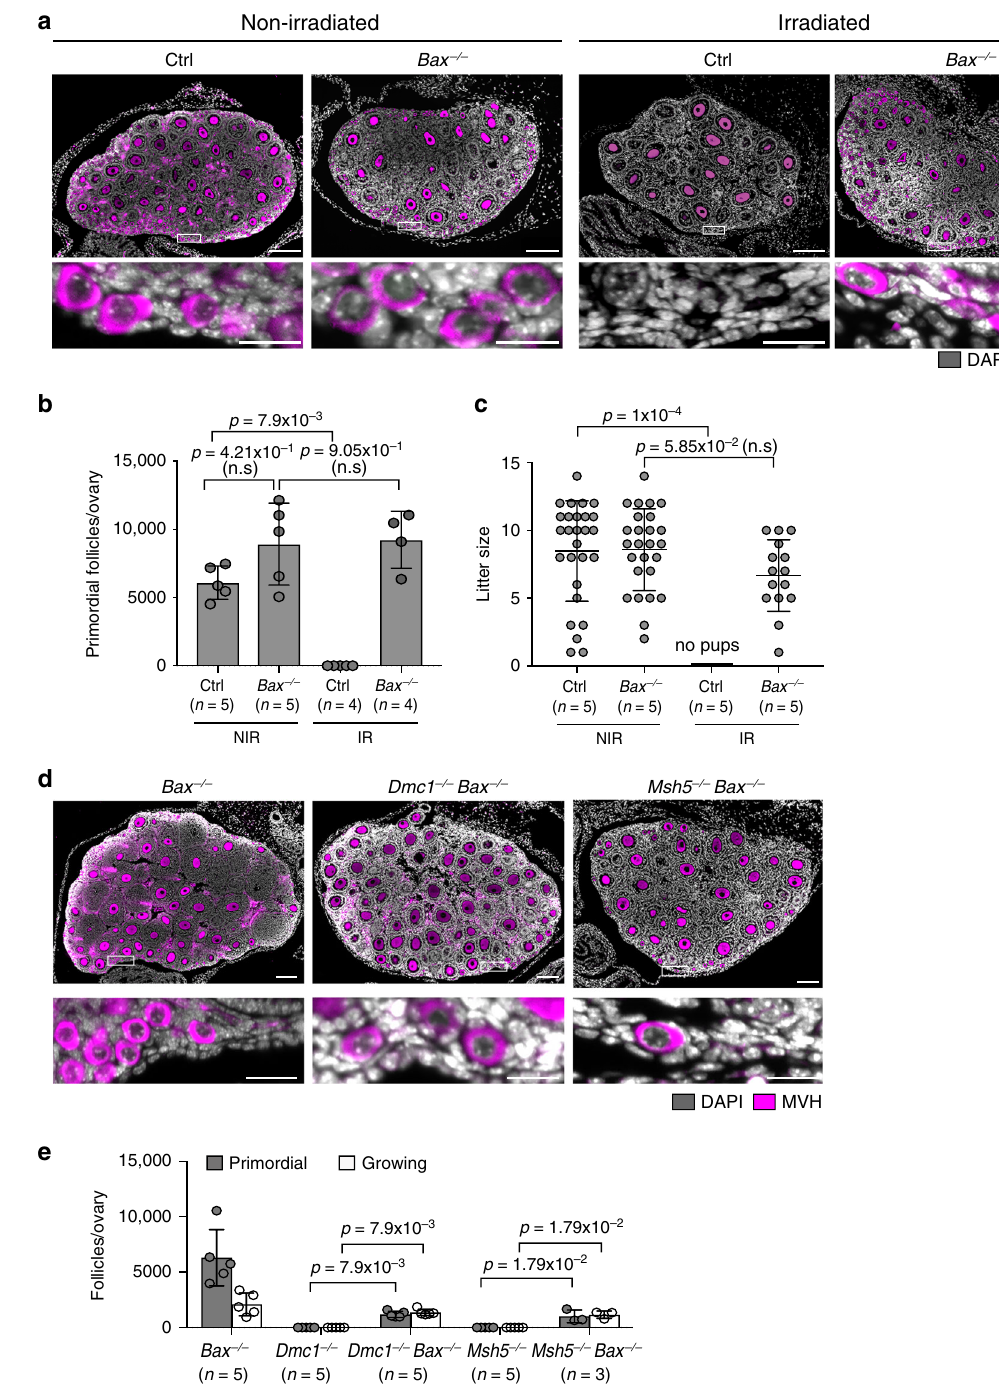
Fig. 2 Bax deletion rescues oocyte loss in Dmc1 and Msh5 nulls. a P10 ovary sections immunostained for oocyte marker MVH (magenta), harvested following 0.45 Gy IR-exposure at P5 (versus non-irradiated; NIR). Control (Ctrl) is Bax + / − . White rectangles in upper panels show cortex, which is magni fi ed in lower panels. b Primordial follicle quantitation at P10. Data are represented as mean ± standard deviation. Error bars indicate 95% con fi dence intervals. Two-sided Mann – Whitney test was used to calculate p -values. c Litter sizes from 6-week-old NIR or IR-treated females ( fi ve mating pairs